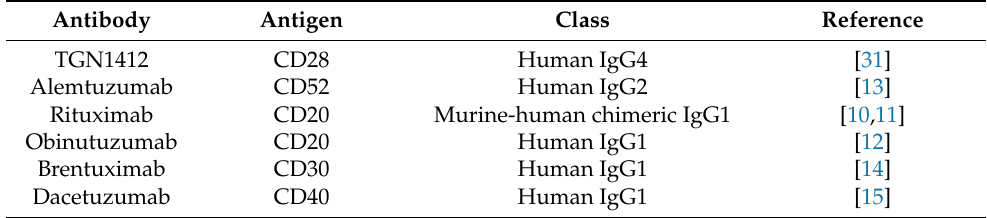
Table 1. Monoclonal antibodies associated with cytokine release syndrome (CRS) in hematologi- cal malignancies.